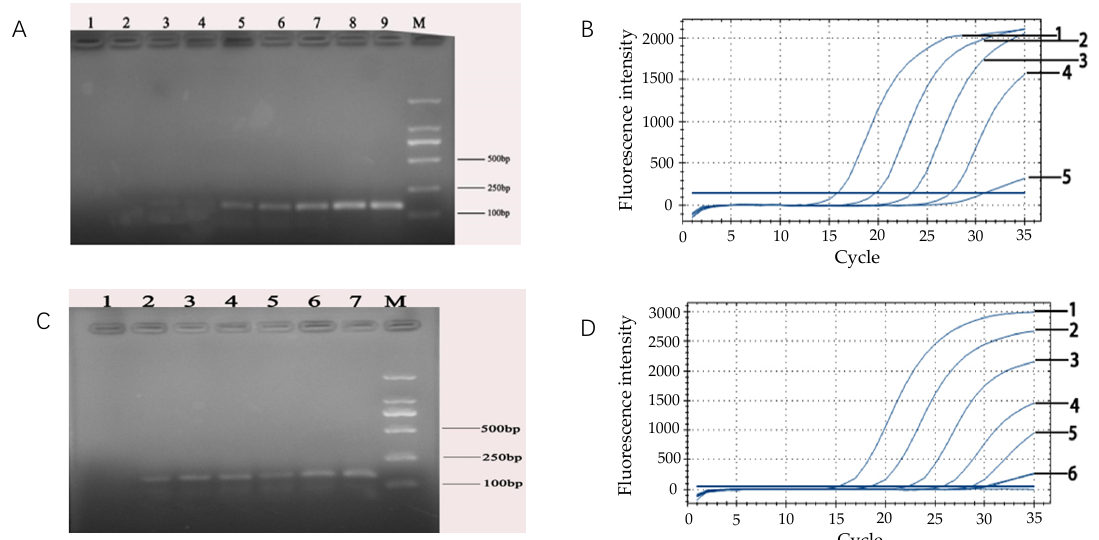
Figure 6. ( A ) Sensitivity of ordinary PCR was based on the di ff erent concentrations of E. coli O157:H7 DNA extracted by the boiling water method.Lane M: DL 2000 DNA ladder; Lane 9: 10 8 CFU / mL; Lane 8: 10 7 CFU / mL, Lane 7: 10 6 CFU / mL, Lane 6: 10 5 CFU / mL, and Lane 5: 10 4 CFU / mL. ( B ) Sensitivity of the real-time fluorescent PCR based on di ff erent concentrations of E. coli O157:H7 DNA extracted by the boiling water method. Line 1: 10 8 CFU / mL; Line 2: 10 7 CFU / mL; Line 3: 10 6 CFU / mL; Line 4: 10 5 CFU / mL; and Line 5: 10 4 CFU / mL. ( C ) Sensitivity of ordinary PCR based on di ff erent concentrations of E. coli O157:H7 DNA extracted by the commercial kit method. Lane M: DL 2000 DNA ladder; Lane 7:10 8 CFU / mL; Lane 6: 10 7 CFU / mL; Lane 5: 10 6 CFU / mL; Lane 4: 10 5 CFU / mL; Lane 3: 10 4 CFU / mL; and Lane 2: 10 3 CFU / mL. ( D ) Sensitivity of real-time fluorescent PCR based on di ff erent concentrations of E. coli O157:H7 DNA extracted by the commercial kit method. Line 1: 10 8 CFU / mL; Line 2: 10 7 CFU / mL; Line 3: 10 6 CFU / mL; Line 4: 10 5 CFU / mL; Line 5: 10 4 CFU / mL; and Line 6: 10 3 CFU / mL.